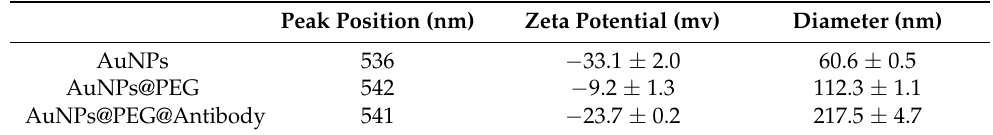
Table 1. Characterization of AuNPs and their